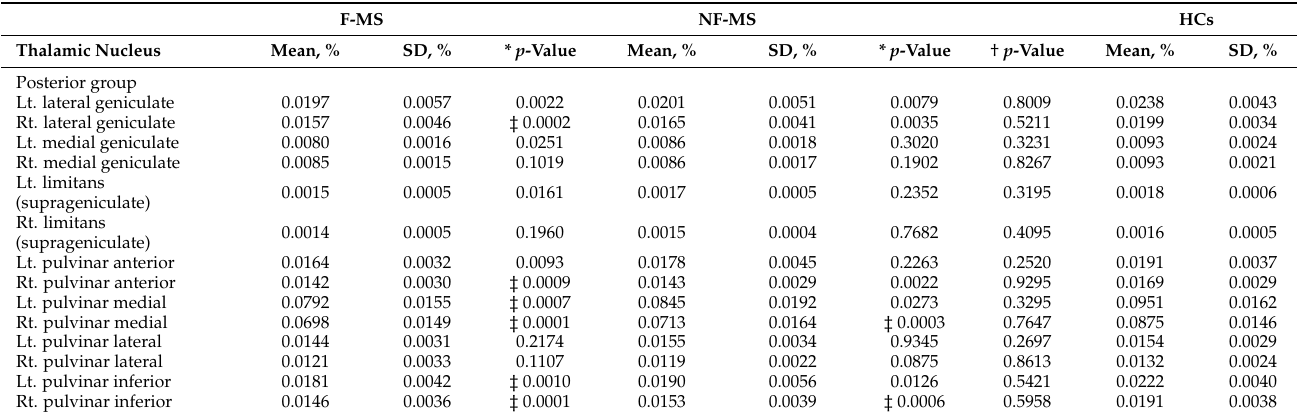
lateral, Pul: pulvinar